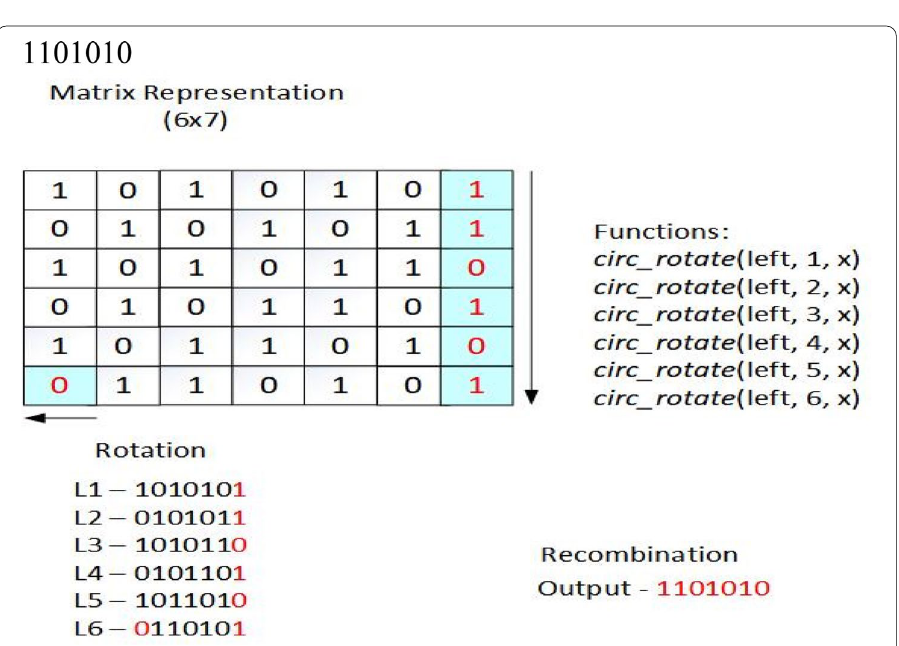
Fig. 8 Result after passing the classical bit string 1101010 through the bit